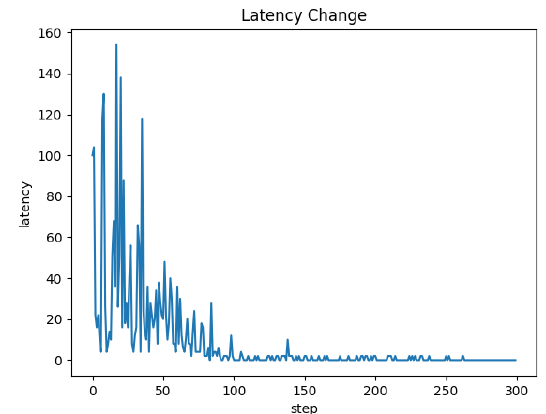
Figure 6. State S’s latency change during learning.